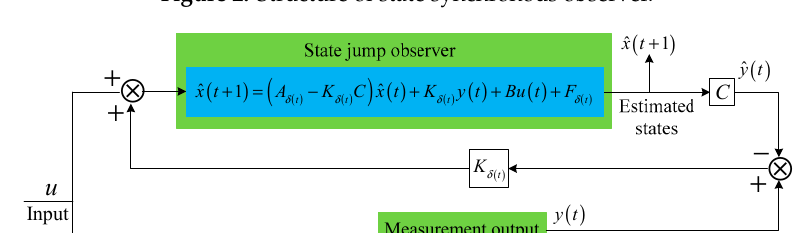
Figure 2. Structure of state synchronous observer.